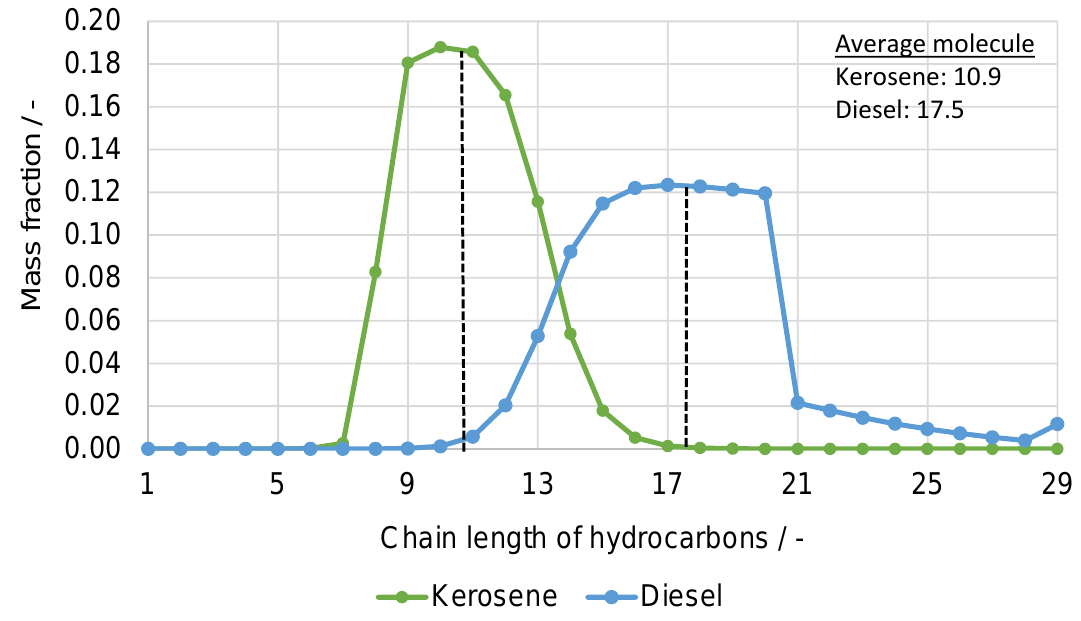
Figure 8. Product distribution of the produced kerosene and diesel fraction.